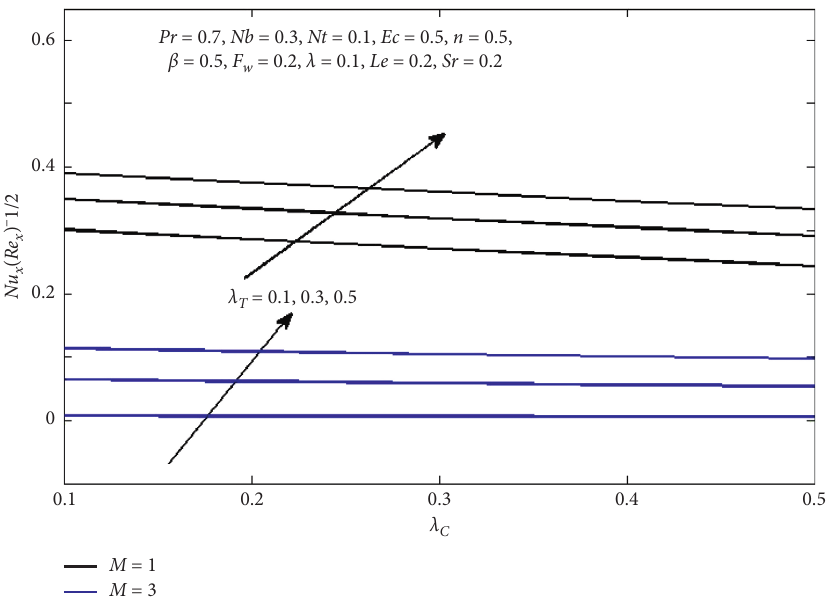
Figure 23: Variation of Nu